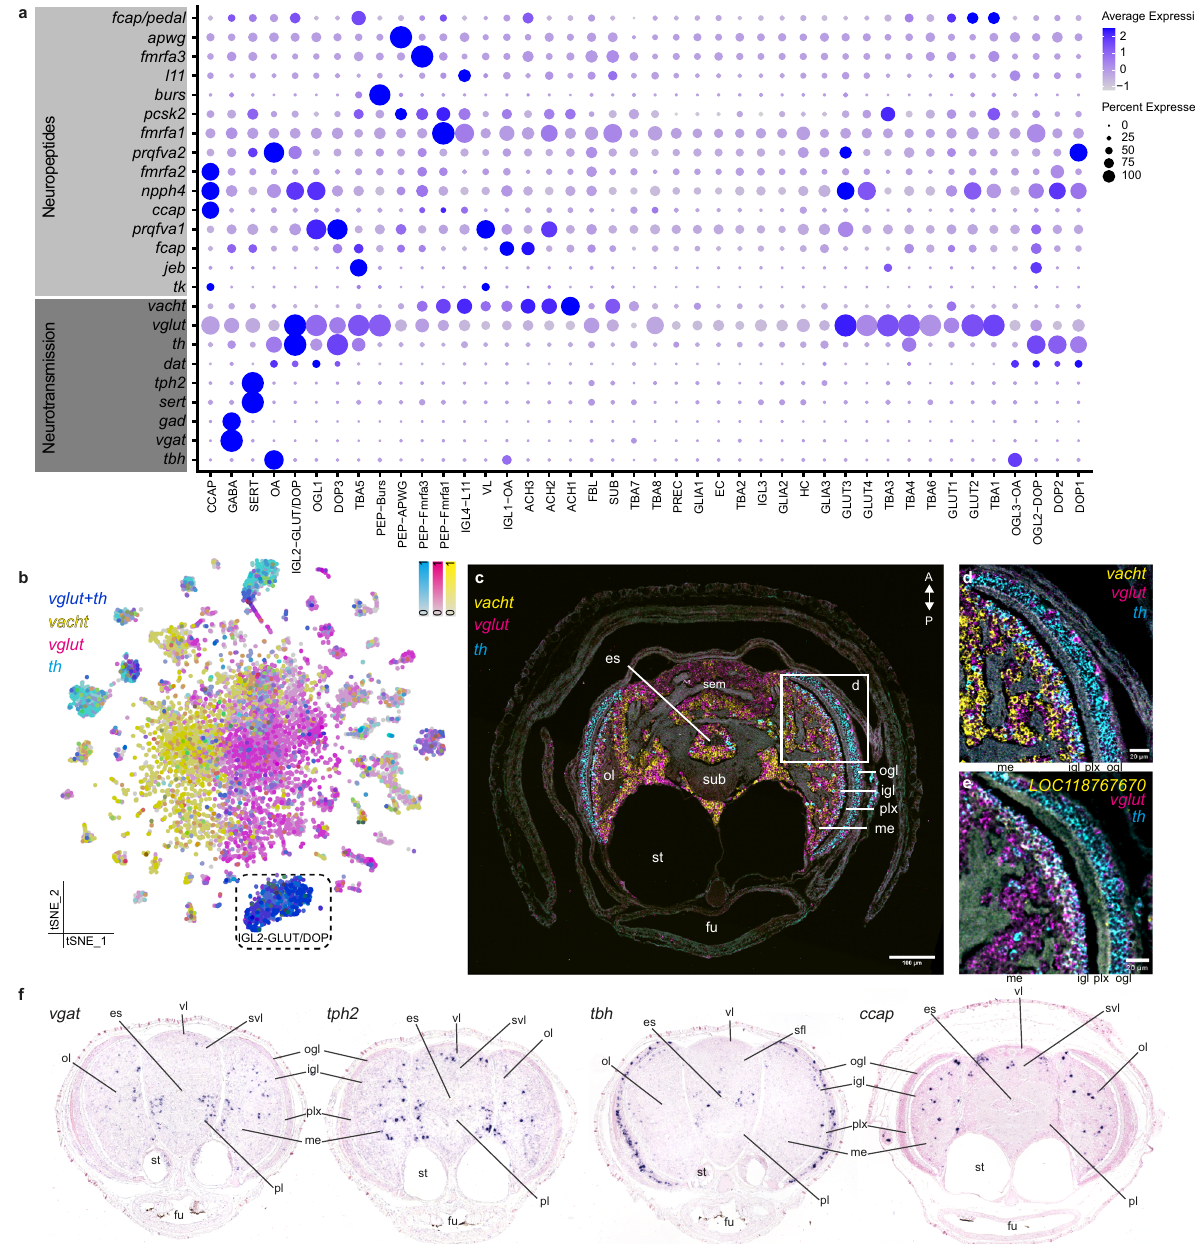
Fig. 2 | Neurotransmitters and peptides. a Dot plot for main neuropeptides and genesinvolvedinthesynthesisandtransportofneurotransmitters. b Expressionof th , vglut ,and vacht isvisualized onat-SNEplot. Th (tyrosine hydroxylase)isshown in cyan, vglut (vesicular glutamate transporter) in magenta, and vacht (vesicular acetylcholine transporter) in yellow. c Multiplexed in situ hybridization chain reaction (HCR) for th , vglut , and vacht . The white square is shown in d at a higher magni fi cation. d Multiplexedinsituhybridizationchainreaction(HCR)intheoptic lobe for th , vglut, and vacht . e Co-expression of th and vglut in the inner granular layer of the optic lobe, together with the cluster-speci fi c marker for IGL2-GLUT/